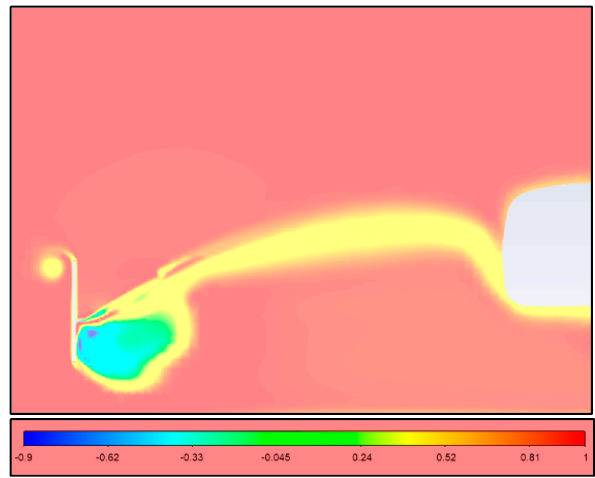
Figure 8. Total pressure coefficient at plane z = − 0.8 (AOA of 30 ◦ , 32 ◦ , and 34 ◦ ).